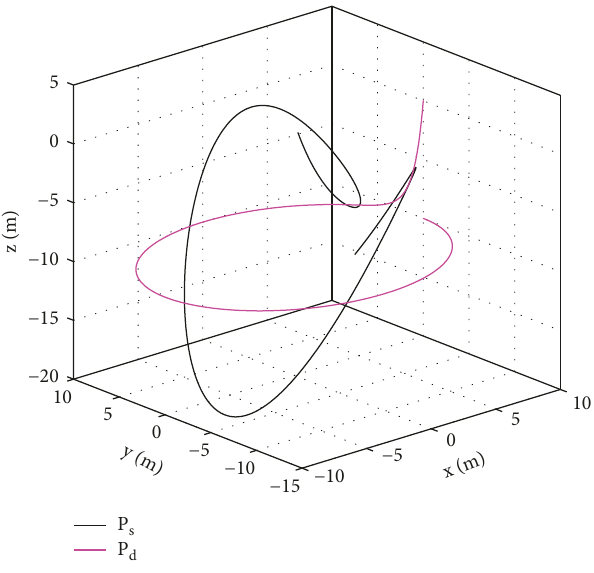
Figure 3: Tracking trajectories y and y